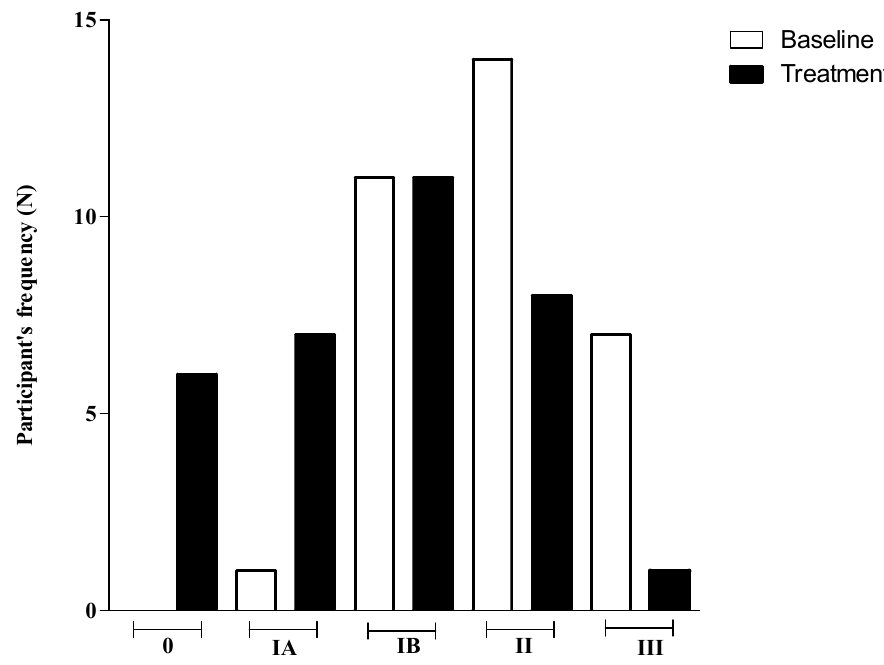
Figure 1. Participant’s frequency (N) according to the degree of denture-related stomatitis, at the baseline and after treatment.